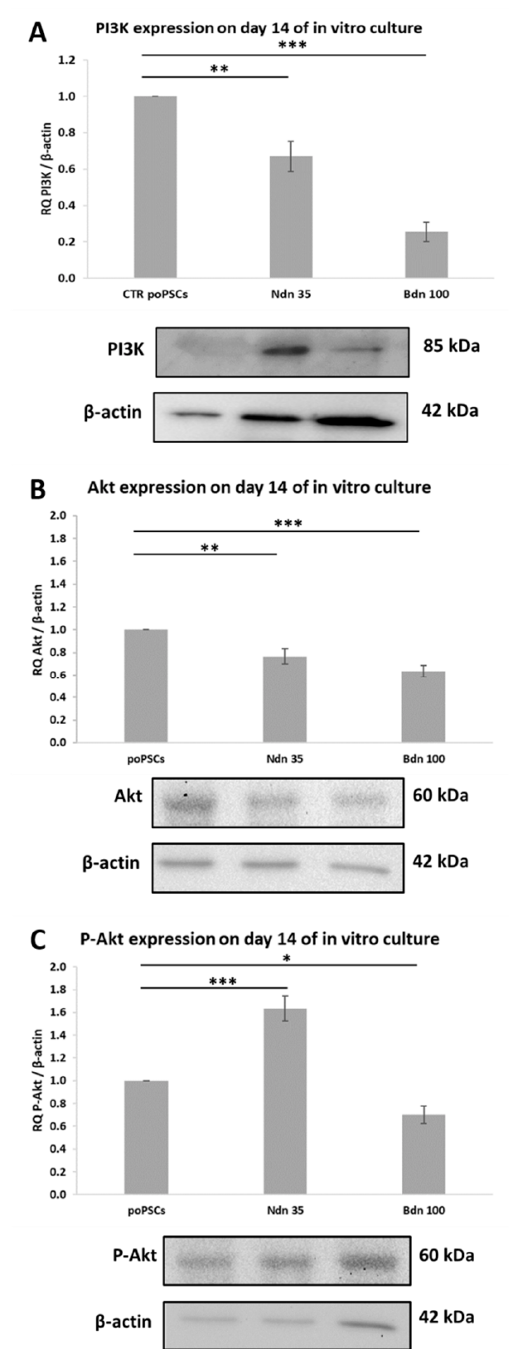
Figure 8. Expression of signaling pathway-related proteins: PI3K ( A ), Akt ( B ), and P-Akt ( C ) at the level of total protein after 14-Day culture in the presence of nandrolone and boldenone. The graphs depict the relative abundances (RAs) noticed for PI3K, Akt and P-Akt proteins obtained from measurements of the optical density of the bands representing a specific signal. Results represent the mean with n = 3 ± standard deviation (SD). Statistical analysis: homogeneity of variance—Levene’s test, normality of distribution—Shapiro–Wilk test, one-way ANOVA, Tukey’s post-hoc test, * p < 0.05; ** p < 0.01; *** p < 0.001.